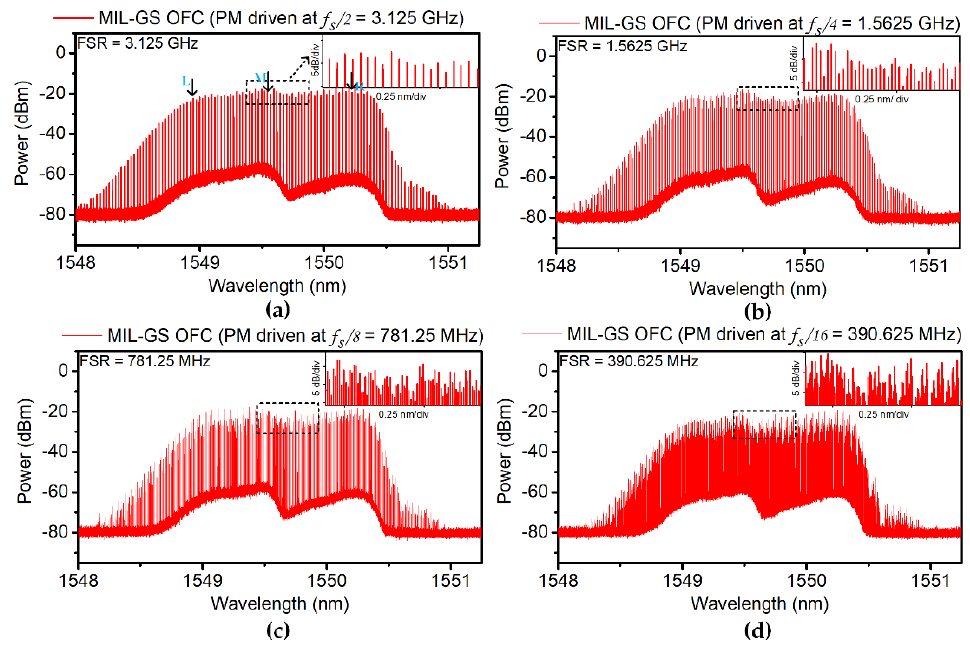
Figure 5. Optical spectra of comb densification MIL-GS OFC with FSR of ( a ) 3.125 GHz; ( b ) 1.5625 GHz; ( c ) 781.25 MHz; ( d ) 390.625 MHz. The insets depict a zoom in on the dotted region (5 dB/div scale). Table 3. Summary of the MIL-GS OFC comb densification.